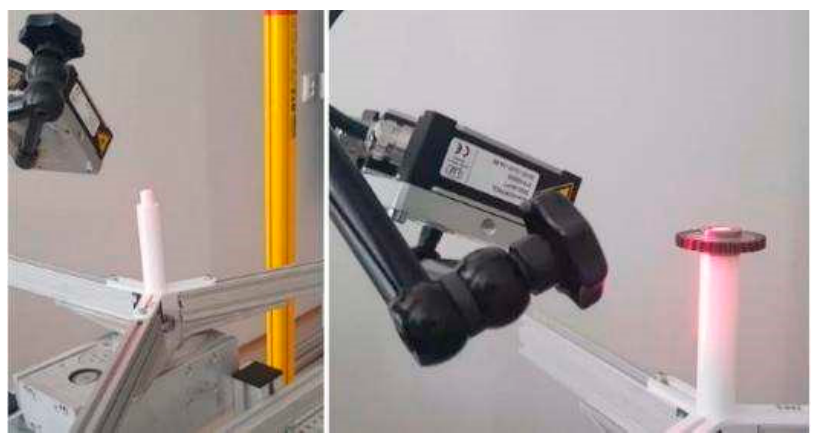
Table 1. Parameters of a laser sensor.